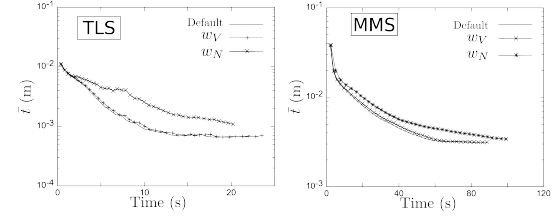
Figure 6: Weighting step results.